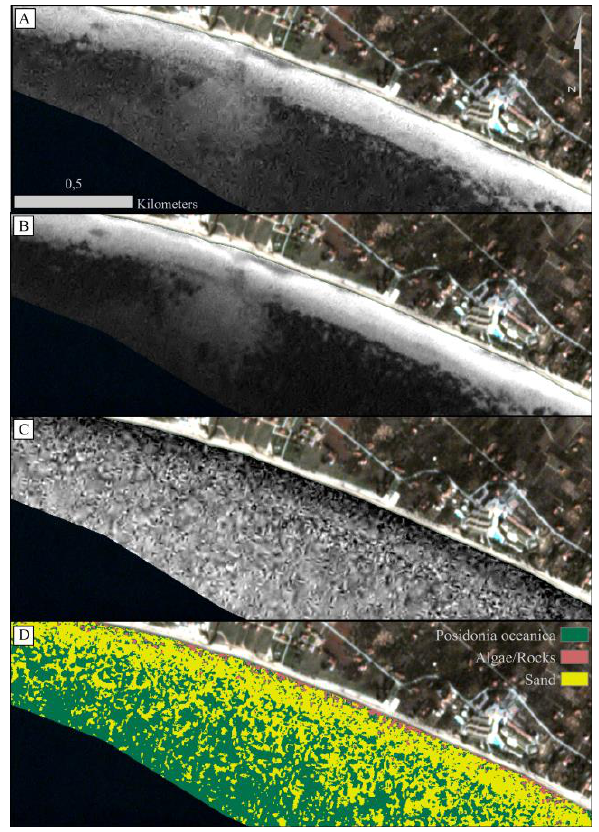
Figure 3. Experimental steps with the application of Unmixing- based denoising. A and B display the denoised blue and green Planet reflectance following the UBD application on the A and B of Fig. 2., respectively. Differences in overall brightness from A and B of Fig. 3 are due to their different histogram stretch. C is the depth-invariant index of A and B after the UBD application. D shows Support Vector Machine classification result of C. All rasters are draped over a PlanetScope analytic Ortho RGB Scene of 17/11/2016 over our test site in Thermaikos Gulf, NW Aegean Sea, Greece, projected in UTM (zone 34) system/WGS84.